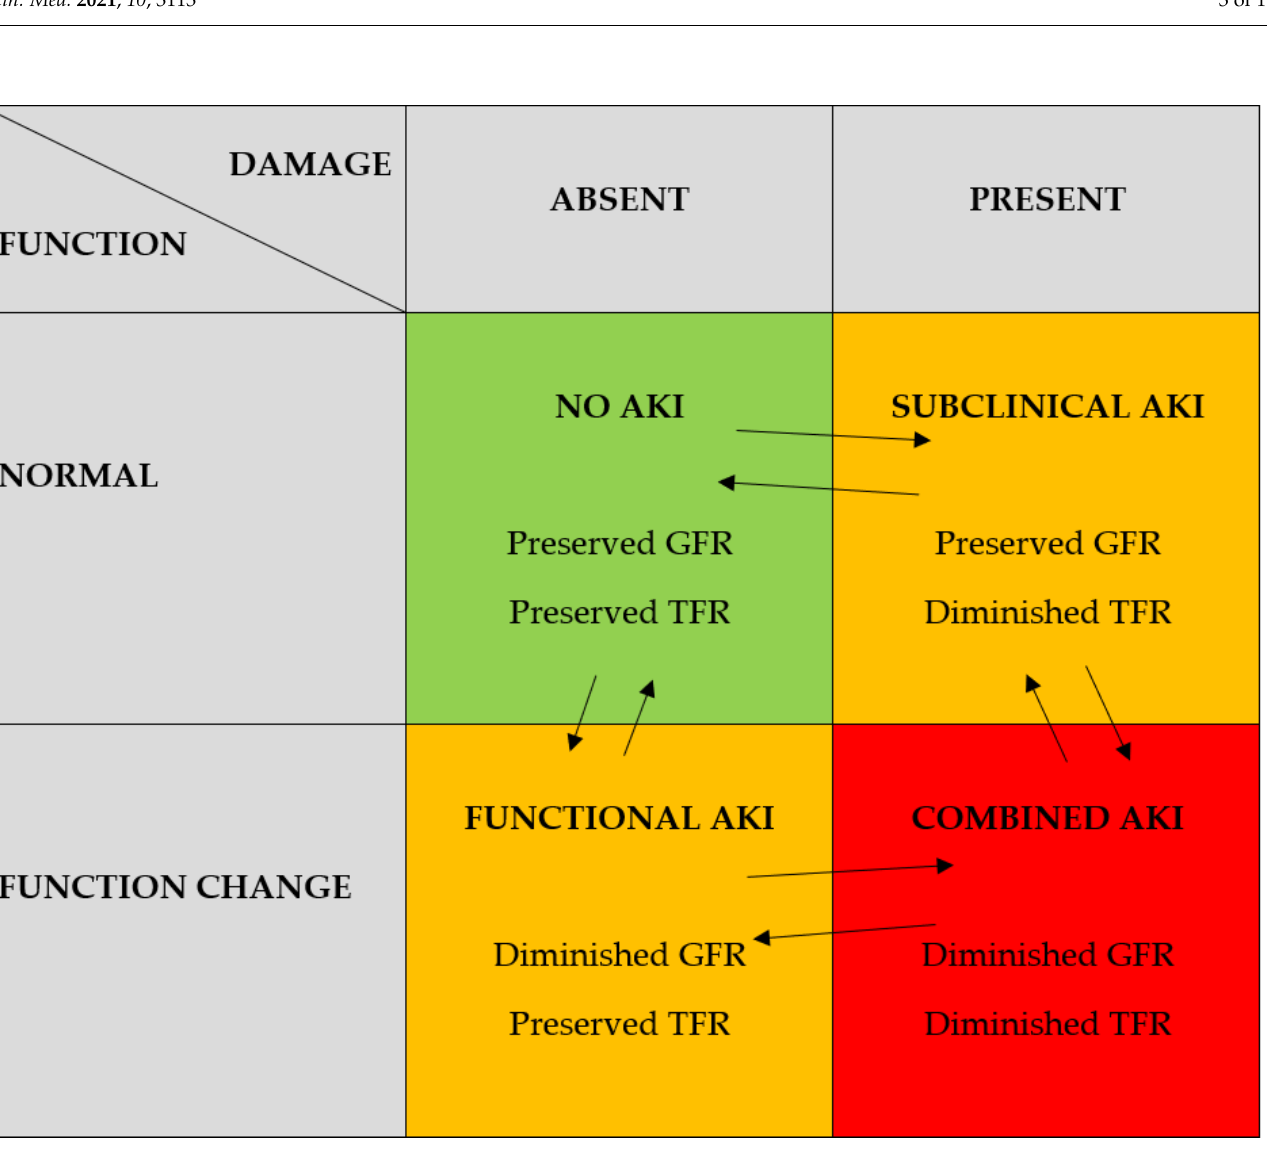
Figure 1. Expanded acute kidney injury (AKI) criteria combining function and damage biomarkers, glomerular functional reserve (GFR), and tubular functional reserve (TFR) (according to [10], modified).